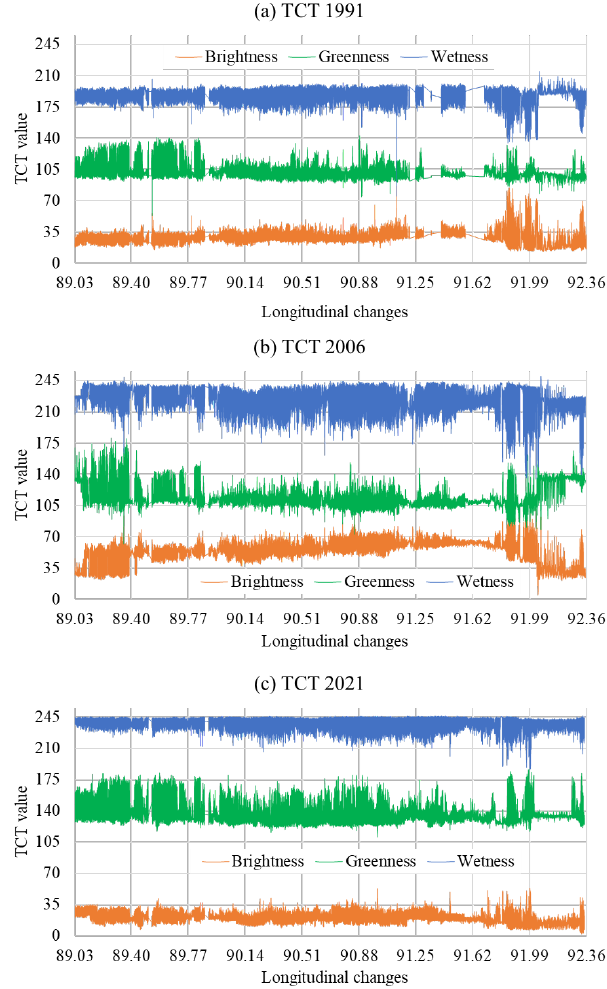
Figure 7. Onshore TCT and longitudinal changes (decimal degree): ( a ) 1991, ( b ) 2006, and ( c ) 2021. Onshore Brightness Index Onshore Greenness